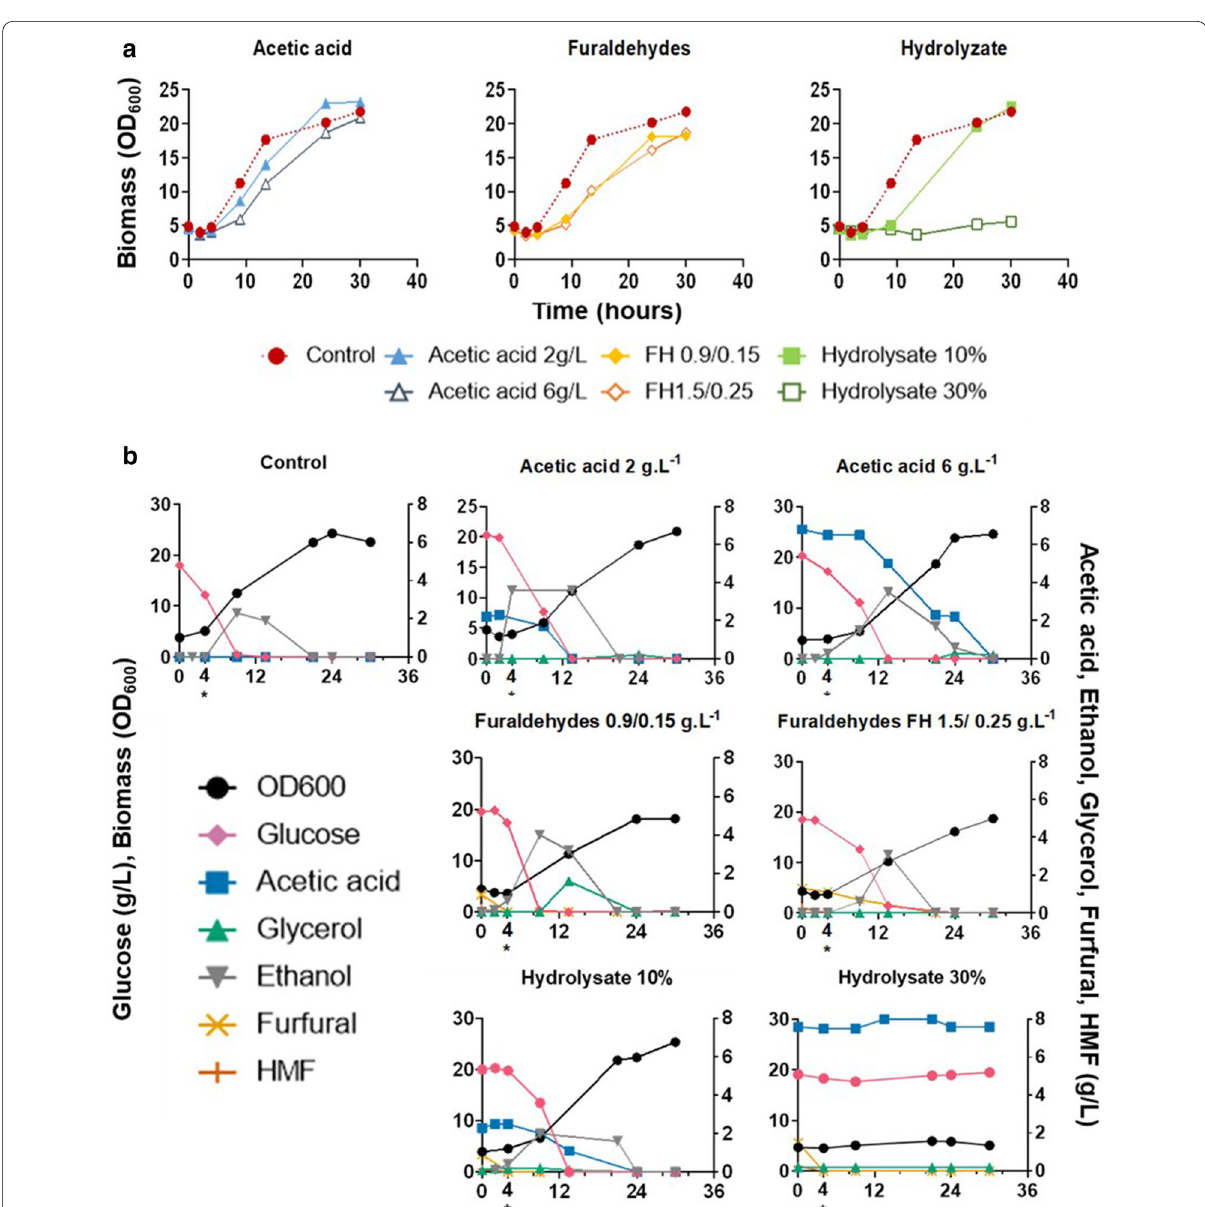
Fig. 1 P. pastoris growth profile in the presence of different inhibitors. a growth curves of: acetic acid (2 g.L − 1 —closed triangle, and 6 g.L − 1 open triangle), furaldehydes (0.15 g.L − 1 HMF, 0.9 g.L − 1 furfural—closed diamond and 0.25 g.L − 1 HMF, 1.5 g.L − 1 furfural—open diamond), and hydrolysate (10%—closed square, and hydrolysate 30% open square) against control (closed circle with dotted lines). b substrate consumption and product formation in different conditions: control, acetic acid 2 g.L − 1 , acetic acid 6 g.L − 1 , FH 0.9/ 0.15 g.L − 1 , FH 1.5/ 0.25 g.L − 1 , hydrolysate 10%, hydrolysate 30%. Biomass (OD600, black circle), glucose (pink diamond), acetic acid (blue square), glycerol (green triangle), ethanol (gray upside-down triangle), furfural (yellow star), HMF (orange cross). Timepoint 4* highlights the timepoint where samples were taken. Xylose concentration was constant through the cultivation. The experiments were performed in triplicate and the figure represents the profile of one